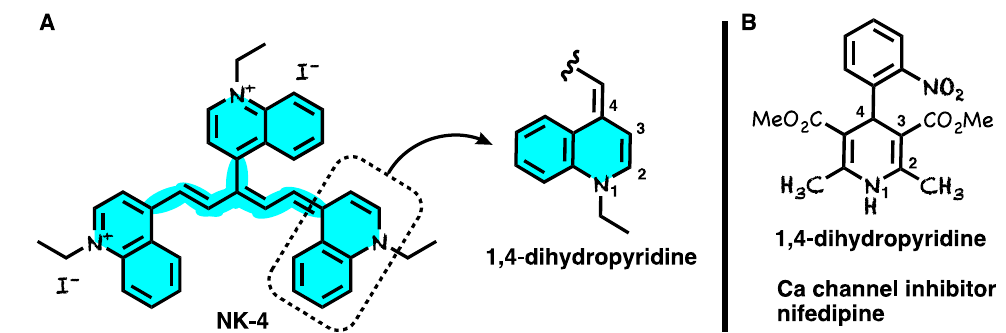
Figure 2. ( A ) Chemical structure of NK-4 having a 1,4-dihydropyridine moiety. ( B ) Structure of Ca channel inhibitor nifedipine having a 1,4-dihydropyridine moiety.